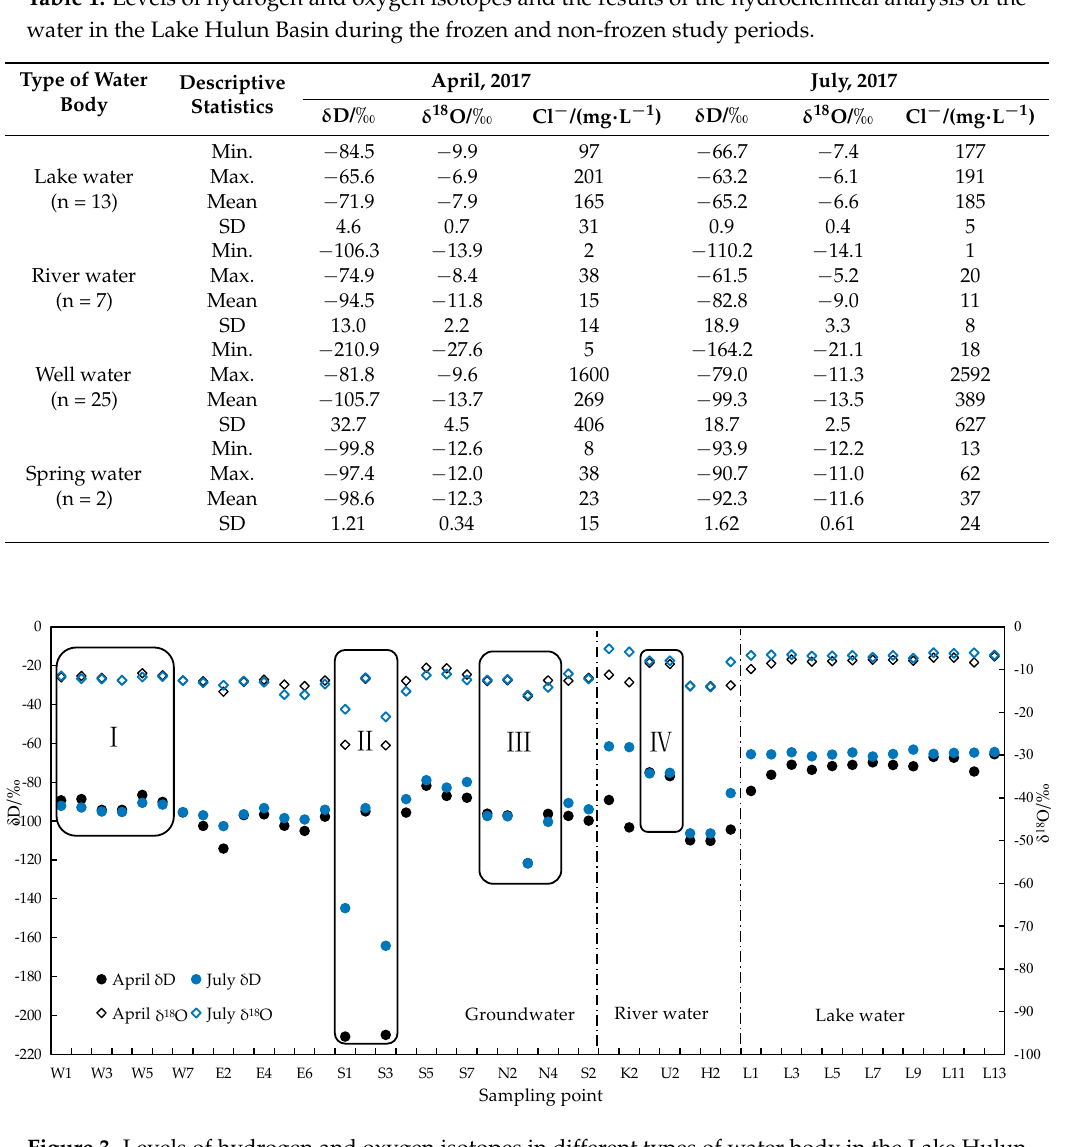
Figure 3. Levels of hydrogen and oxygen isotopes in different types of water body in the Lake Hulun area during frozen and non-frozen periods.